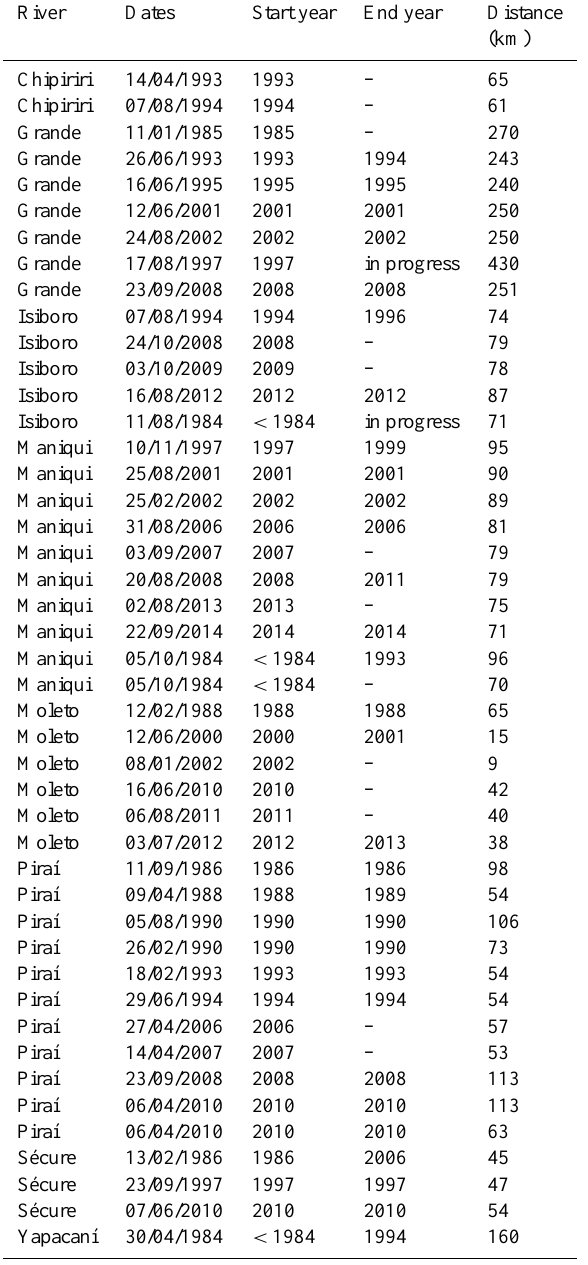
Table 2. Tributaries of the Río Mamoré: crevasse splays and avul- sion events since 1984. Dates refer to the day in which the image used to identify crevasses and avulsions was taken; Start year is the year in which the crevasse is first identified; End year is the year in which the avulsion is completed, when the totality of the river flow is diverted into a new channel; Distance is the down-valley distance of the crevasse from the point where the river enters the alluvial plain, expressed in kilometre. No data in End year indicates that the crevasse did not develop into an avulsion.